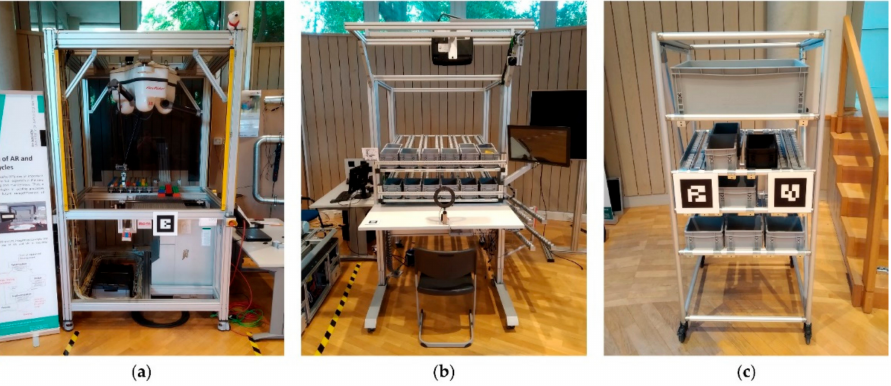
Figure 15. Workstations in model factory to be approached by the mobile manipulator. ( a ) Robot cell with delta picker; ( b ) manual workbench with augmented reality support; ( c )